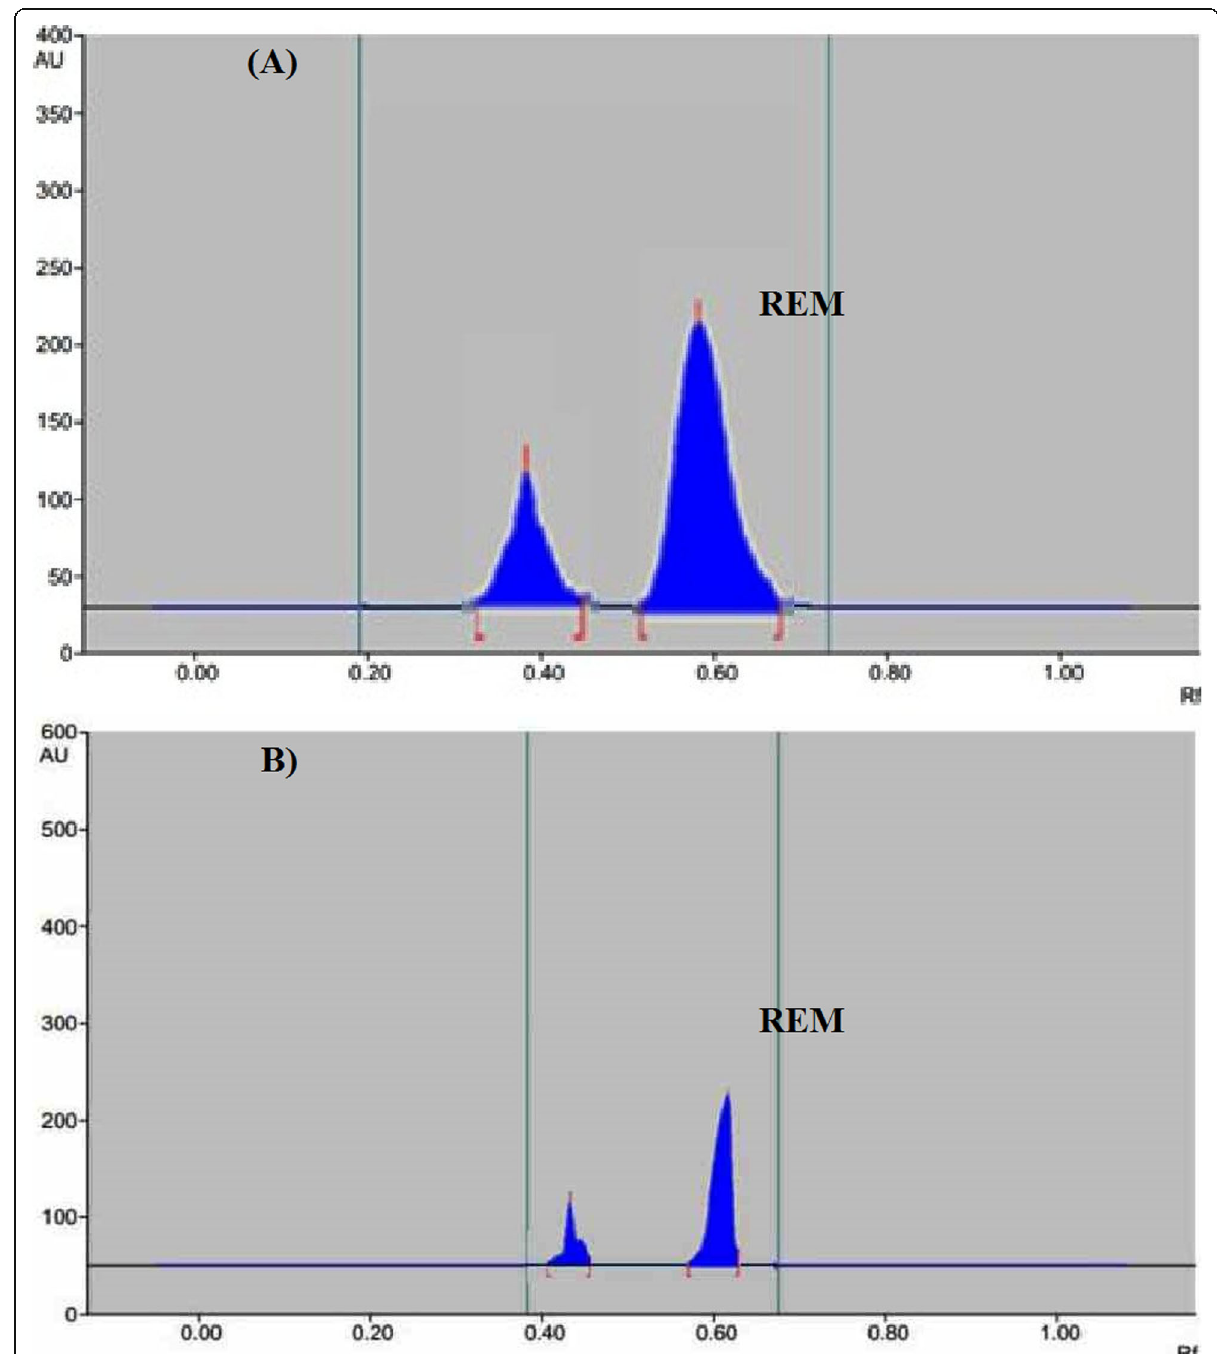
Fig. 6 Densitogram of forced degraded samples. a 0.1N HCl-treated REM for 30 min at 70 °C and b 3% H 2 O 2 -treated REM for 30 min at 70